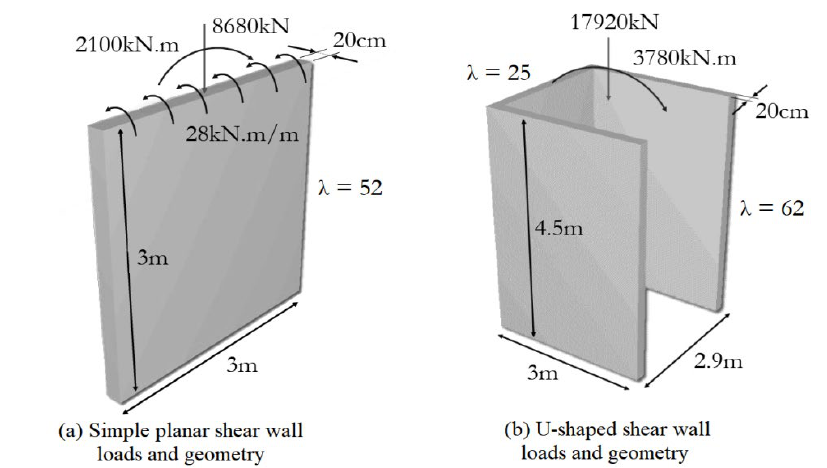
Figure 7. Shear walls loads and geometry [3], [9],